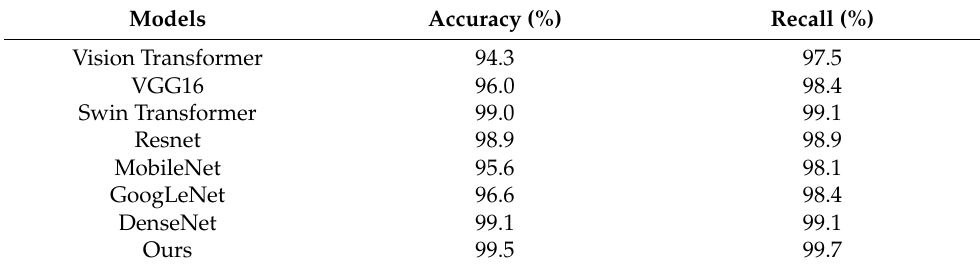
Table 6. Comparison